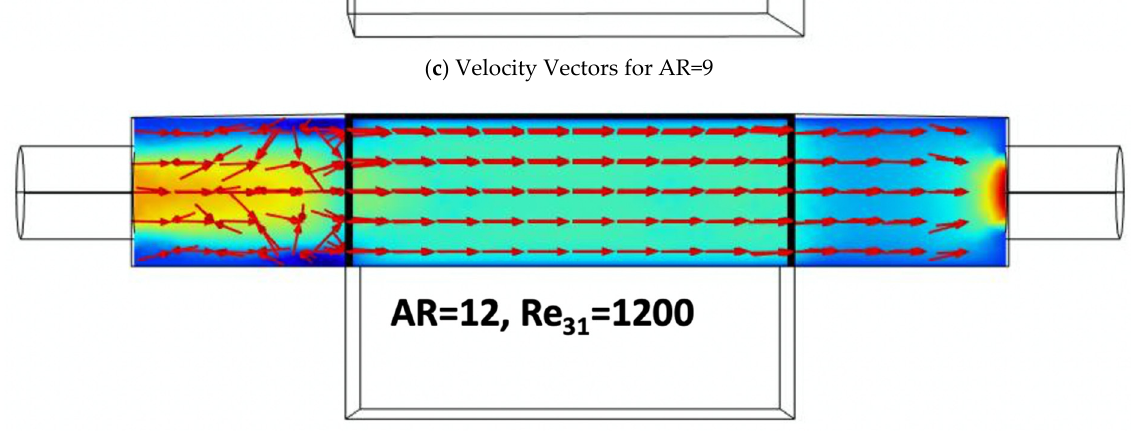
Figure 15. Flow behavior is at the center of the setup for different aspect ratios.